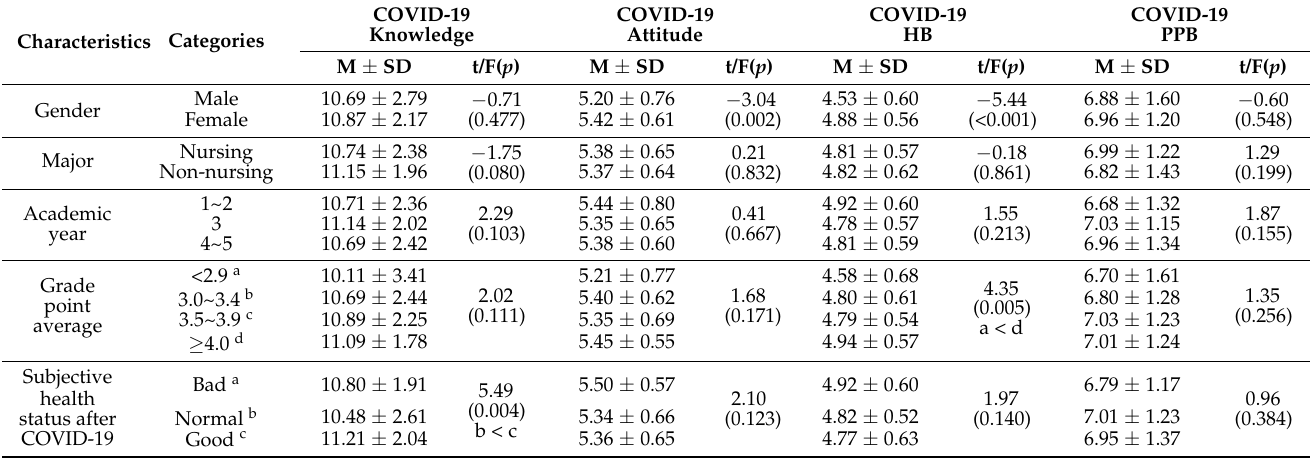
Table 2. Differences in COVID-19 Health Belief, Knowledge, Attitude, and Practice of Prevention Behavior according to General Characteristics ( n =